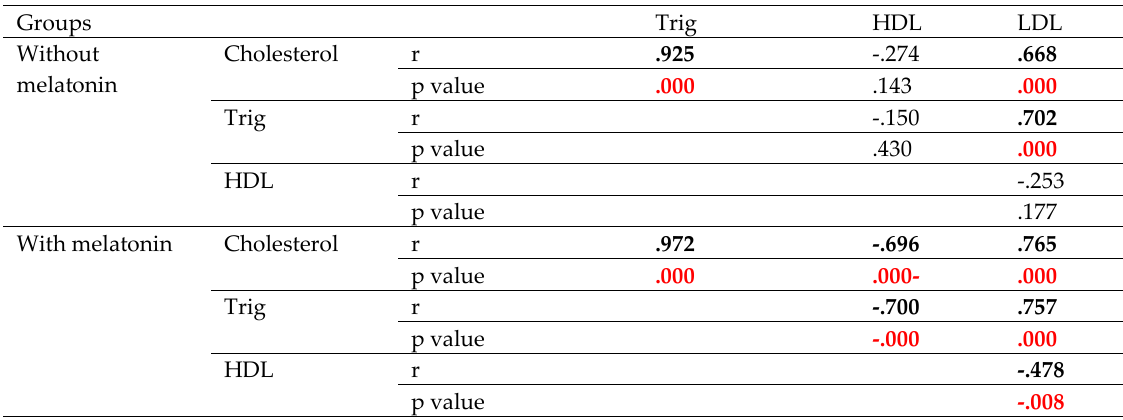
Table 6: Correlation between lipid profiles in recall visit in each